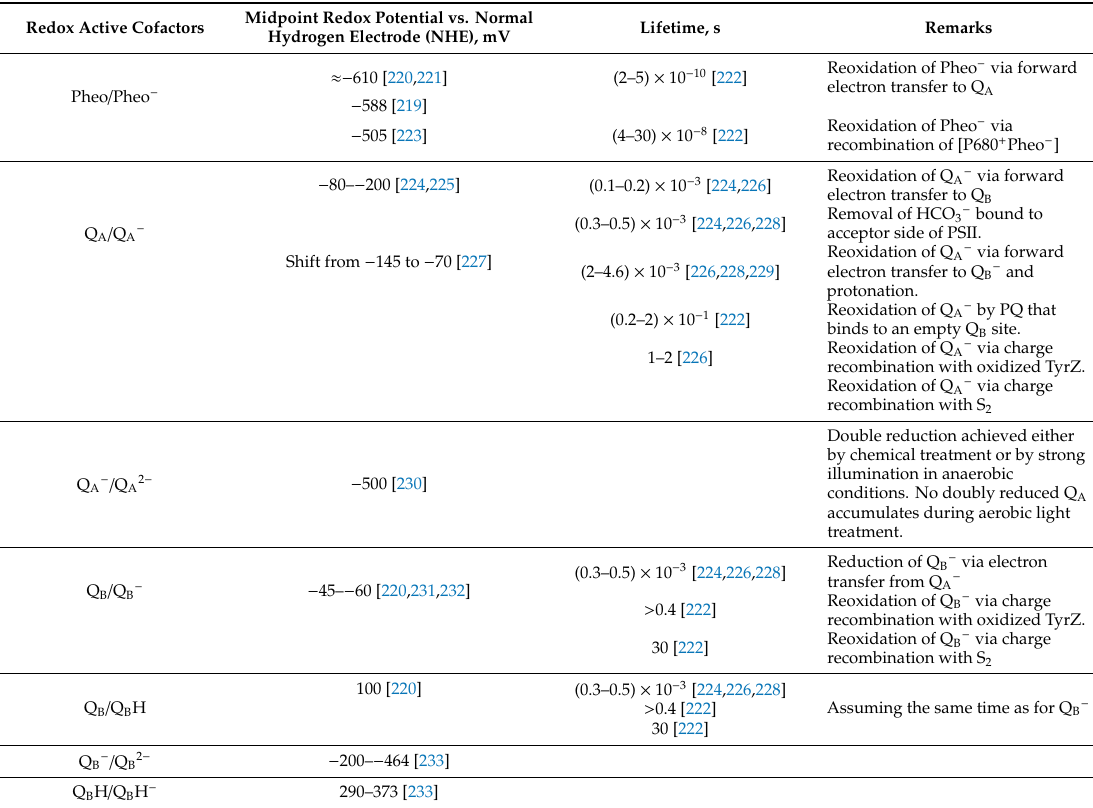
Table 2. Redox midpoint potentials and lifetimes of primary and secondary electron acceptors in PSII. The values were taken from